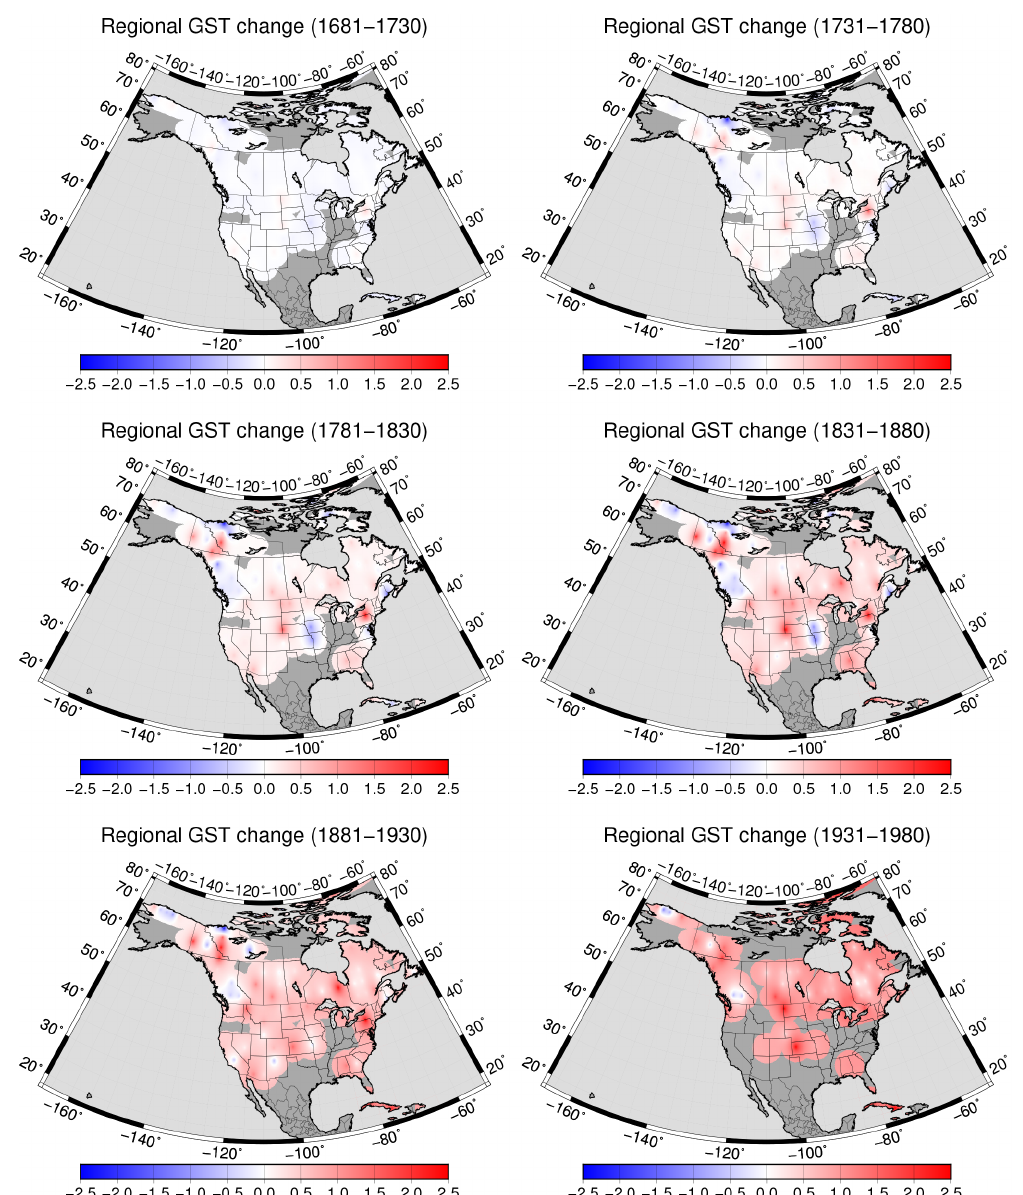
Figure 8. Spatial variability in the GST variation (in kelvin) from 1681 to 1980. Each panel shows a regionally interpolated mean GST over 50 years. The surface has been masked for zones without at least one datum within a radius of 400km. Ground surface temperature changes are presented as departures from long-term mean surface temperatures prior to 1500CE.